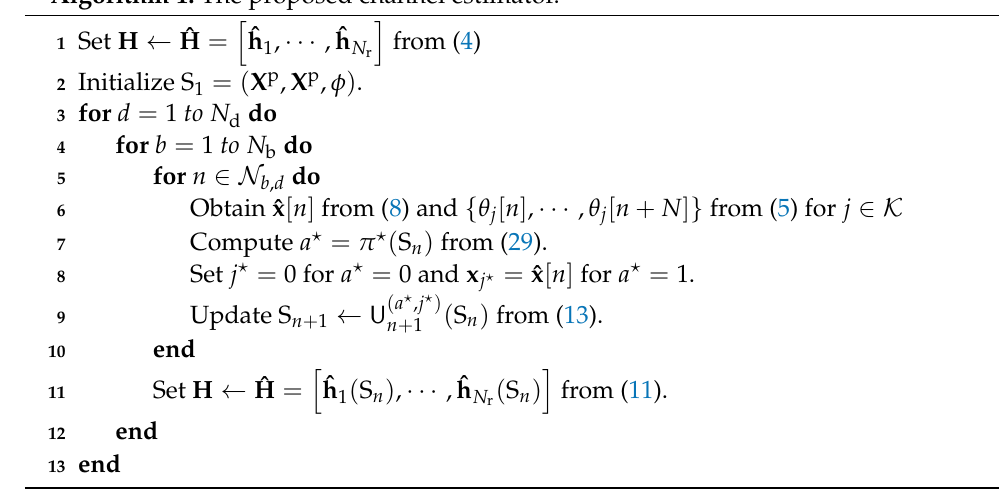
Algorithm 1: The proposed channel